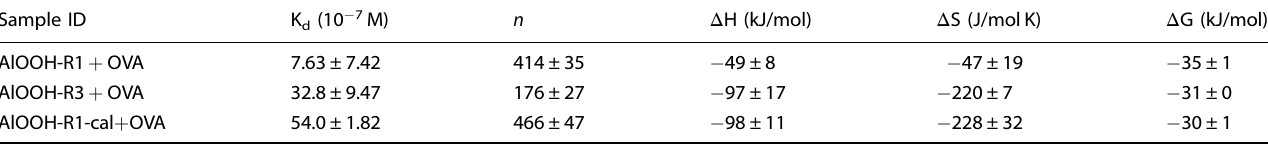
Table 4. Thermodynamic parameters measured by ITC for the binding of OVA to R1, R3, and calcinated R1 nanorods at 25 °C. Sample ID